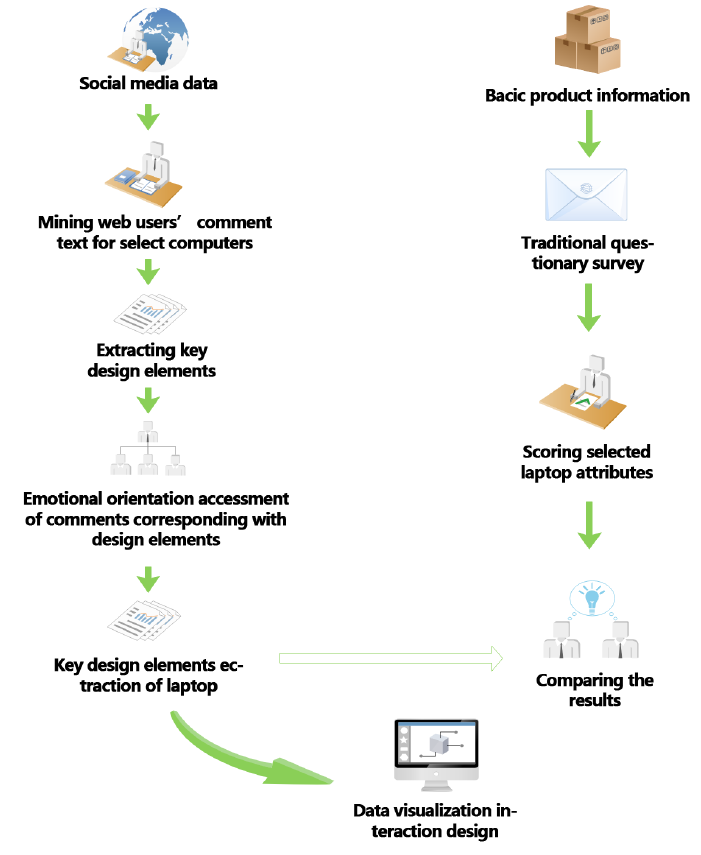
Figure 1. Design demand trend acquisition